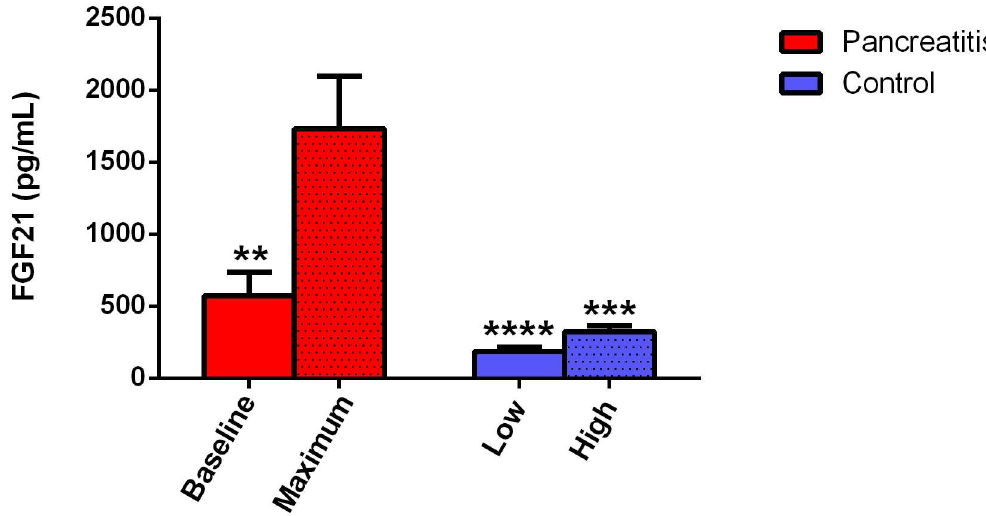
Fig 2. Maximum FGF21 levels in acute pancreatitis are significantly greater than baseline levels and control levels. The baselineFGF21 level for acute pancreatitissubjectsis the lower value of either the first or last measuredFGF21 level duringa hospitalcourse. Data shown as mean ± SEM. N = 25 for acute pancreatitis, N = 20 for control subjects. ** P < 0.01 comparedto maximum levels; *** P < 0.001 comparedto maximum levels; **** P < 0.0001compared to maximum